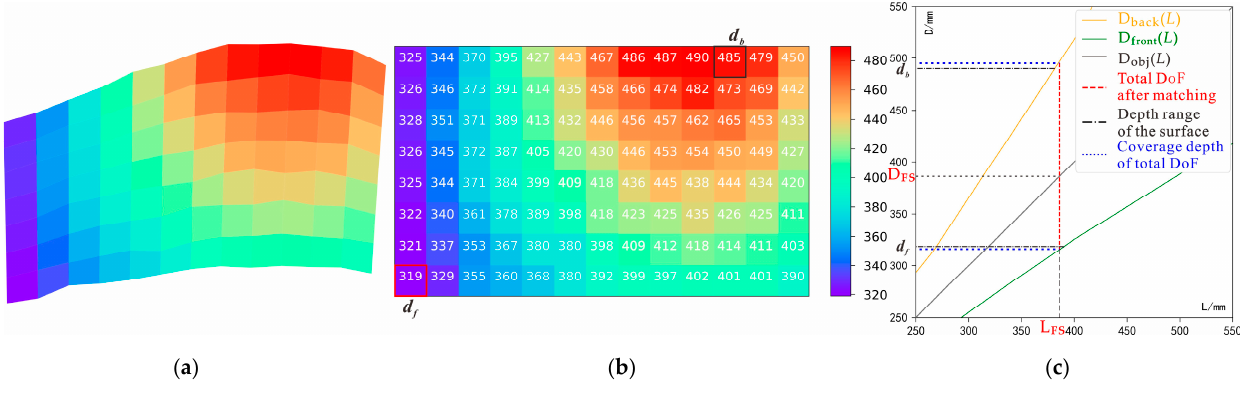
Figure 7. Decision-making process of the all-in-focus scheme at viewpoint i : ( a ) result of surface simulation at viewpoint i ; ( b ) data of depth distribution at viewpoint i; ( c ) all-in-focus imaging scheme at viewpoint i.